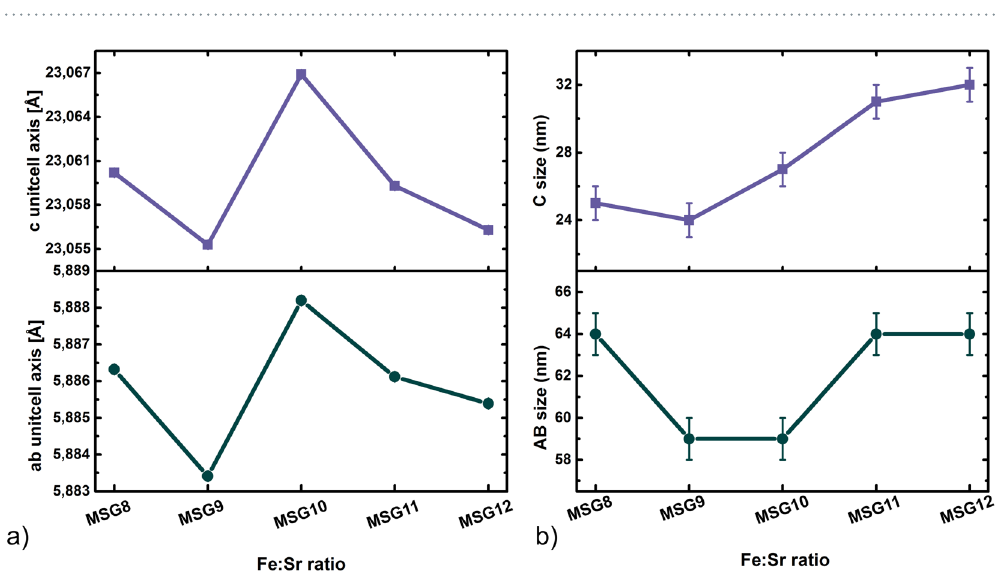
Figure 3. ( a ) Unit cell axis for SrFe 12 O 19 prepared by MSG at different Fe 3 + :Sr 2 + molar ratios ( = 8–12). ( b